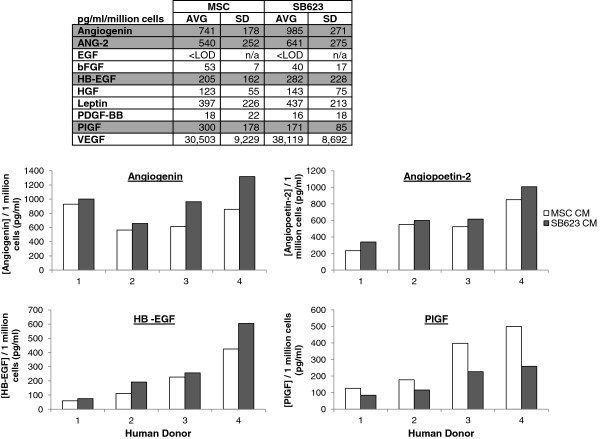
MSCs and SB623 cells secrete pro-angiogenic factors. The table shows average concentration of angiogenic cytokines found in OptiMEM conditioned for 72 hours by either MSCs or SB623 cells from 4 matched human donor lots. Note the relatively high expression of VEGF compared to other cytokines present. Grey highlights indicate factors which are consistently different between MSCs and SB623 cells. These 4 cytokines are plotted by donor showing that, though there is a lot of donor variability, there are consistent trends across multiple donors.